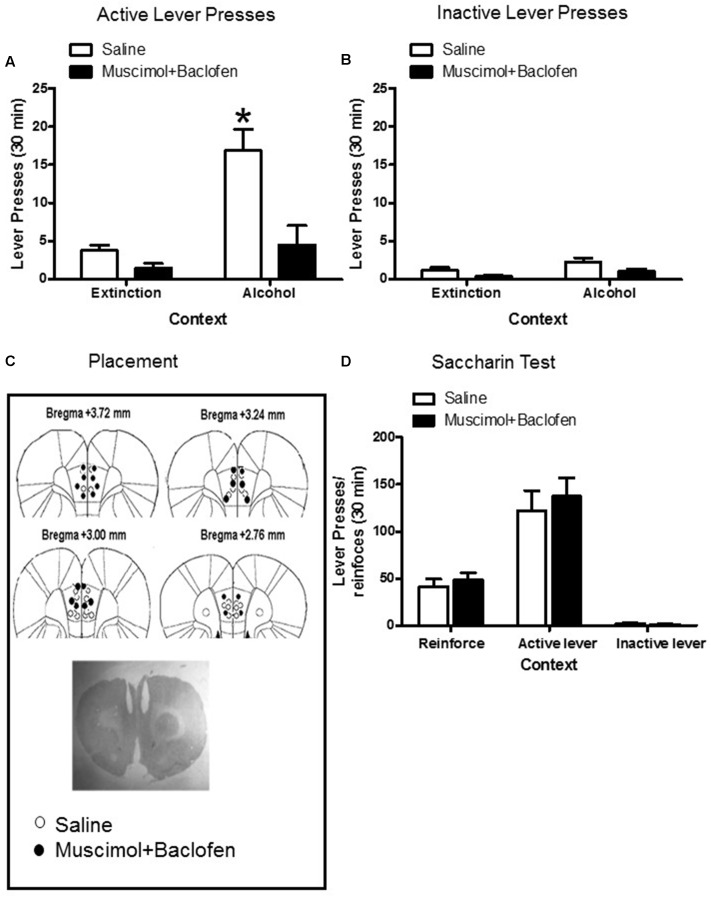
Muscimol + Baclofen inactivation of the prelimbic cortex decreased the context-induced reinstatement of ethanol self-administration. (A) Total active lever-presses during the context-induced reinstatement of ethanol seeking on the test day. (B) Total inactive lever-presses during the context-induced reinstatement of ethanol seeking on the test day (n = 6–9 per group). (C) Dots indicate the approximate area of the injector tip. (D) Local inactivation of the prelimbic cortex with muscimol+baclofen had no effect on high-rate 0.2% saccharin reinforcements responding (n = 8–10 per group). Data are depicted as mean ± standard error of the mean. ∗Different from extinction context B, p < 0.05.